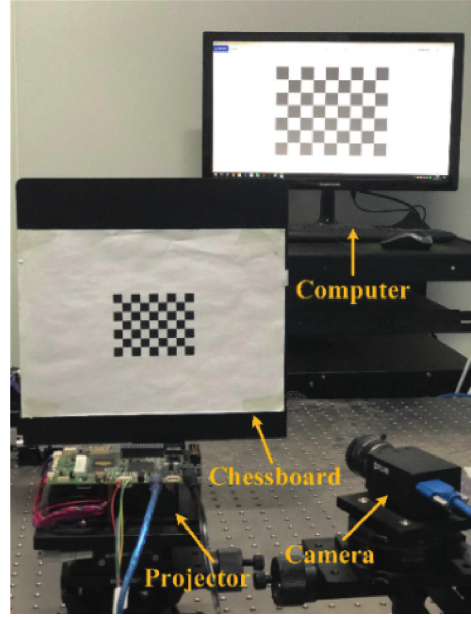
Figure 6: 3D measurement system based on fringe